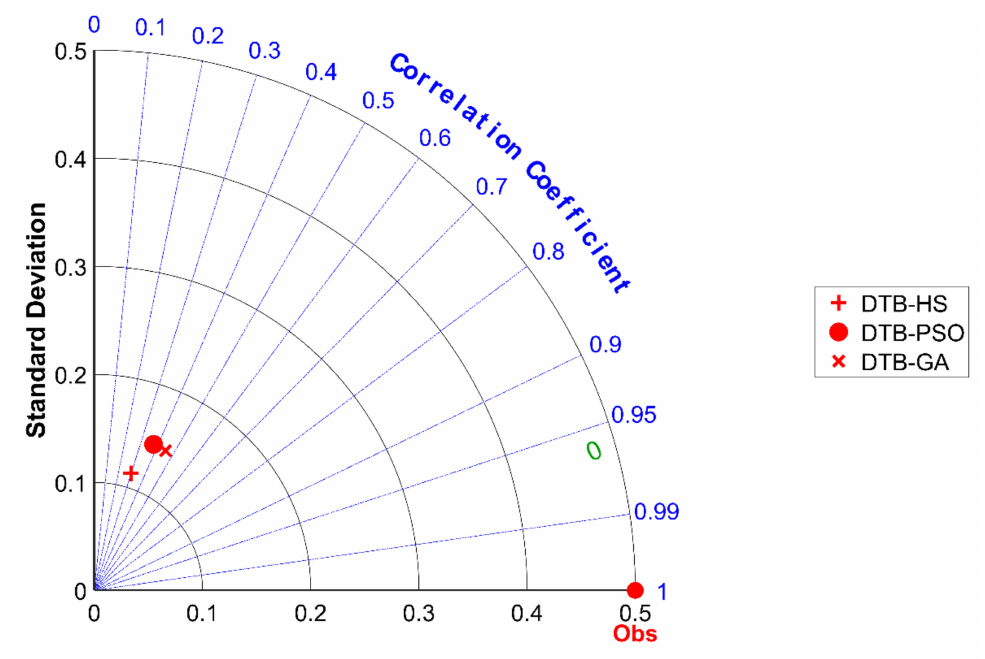
Figure 11. Taylor diagram of hybrid